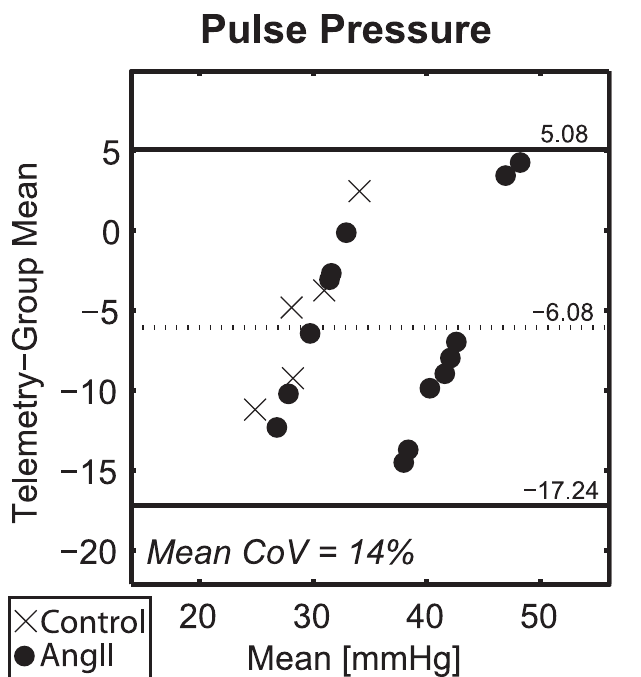
Fig 5. Comparison of Individual Pulse Pressure Measurements under Anesthesia to Conscious Group Average. Bland-Altman plot comparing individual telemetry assessments of pulse pressure under anesthesia and the corresponding group averaged conscious pulse pressure for the same day. Circles denote subjects infused with AngII while ‘ x ’ s denote controls. Overlaid numbers represent the measurement bias (adjacent to the dotted lines) and 95% limits of agreement (adjacent to solid lines). The mean coefficient of variation (CoV) is also